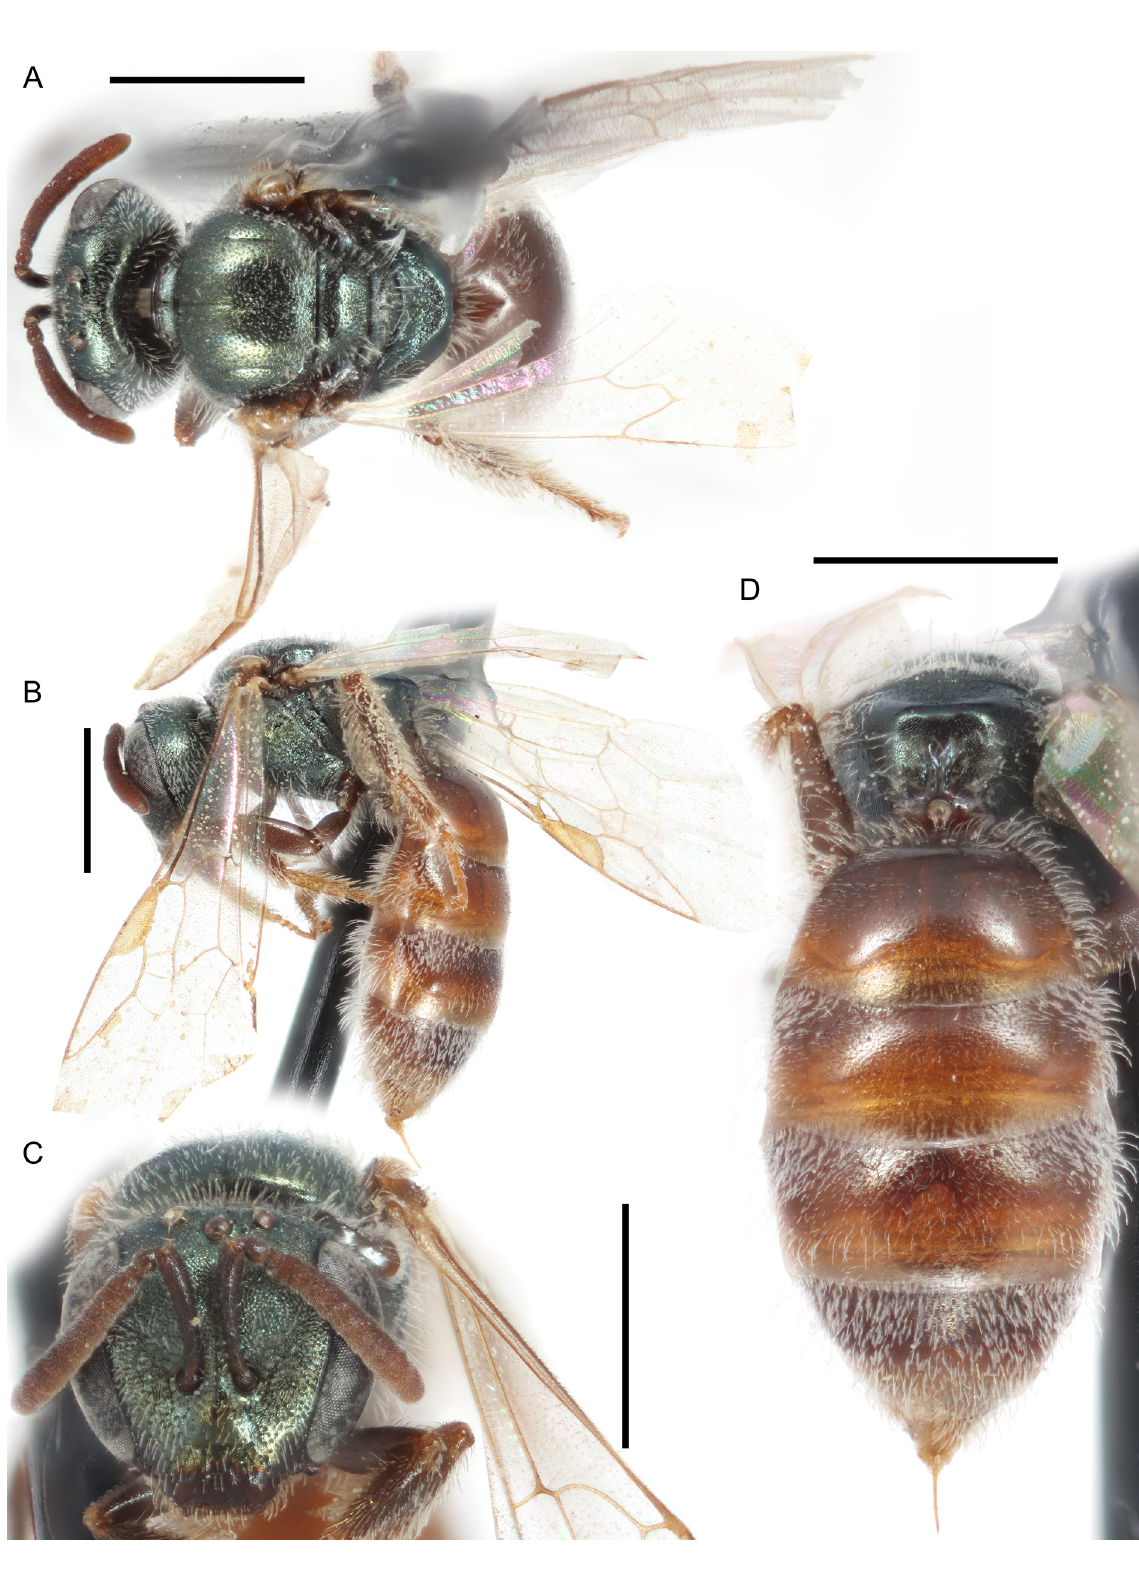
Fig. 61. Lasioglossum ( D. ) miltolepoides sp. nov., ♀. A . Dorsal habitus. B . Lateral habitus. C . Face. D . Propodeum and metasoma. Scale bars: 1